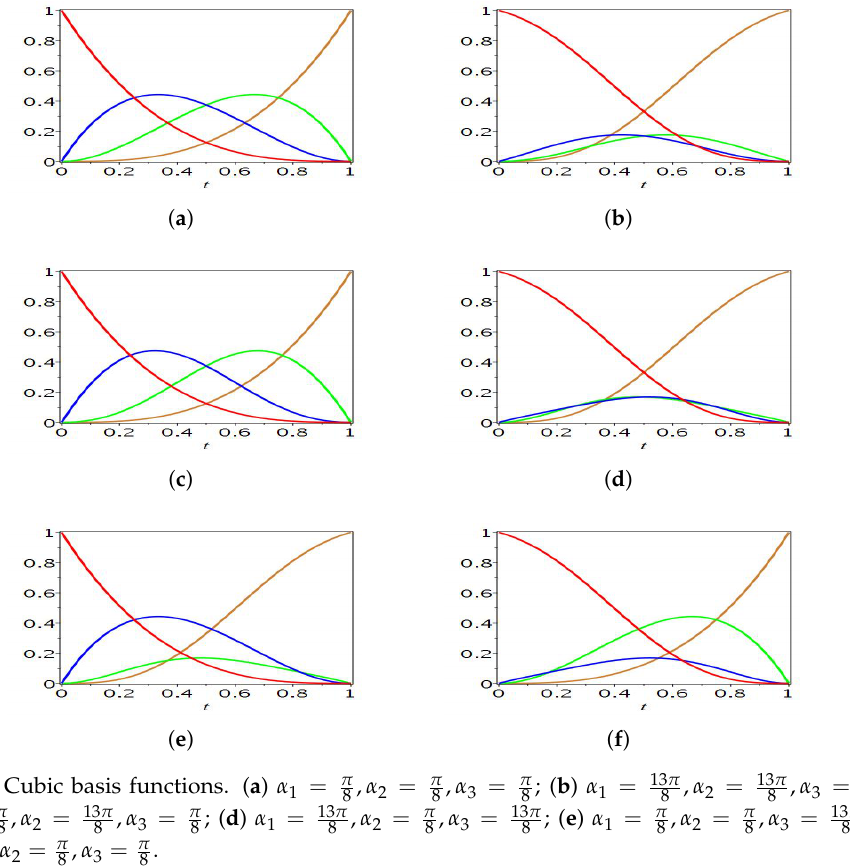
, α 2 = 13 π , α 3 = π ; ( d ) α 1 = 13 π 8 8 8 , α 2 = π , α 3 = π 8 8 8